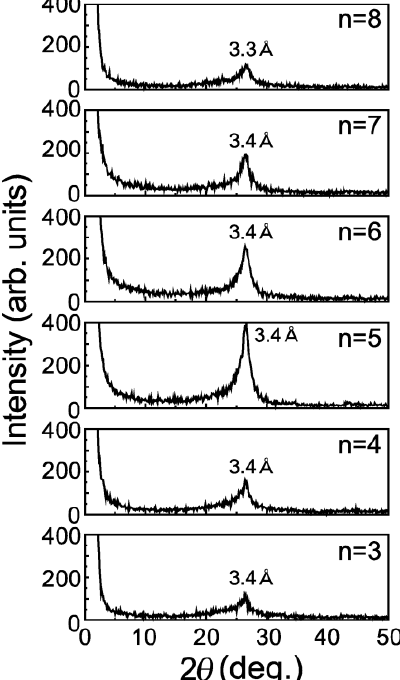
Figure 3. XRD intensity from the alkylamine-intercalated graphite oxide (GO-amine) specimens after heating for 80 minutes at 100 ºC under a high vacuum of 10 −6